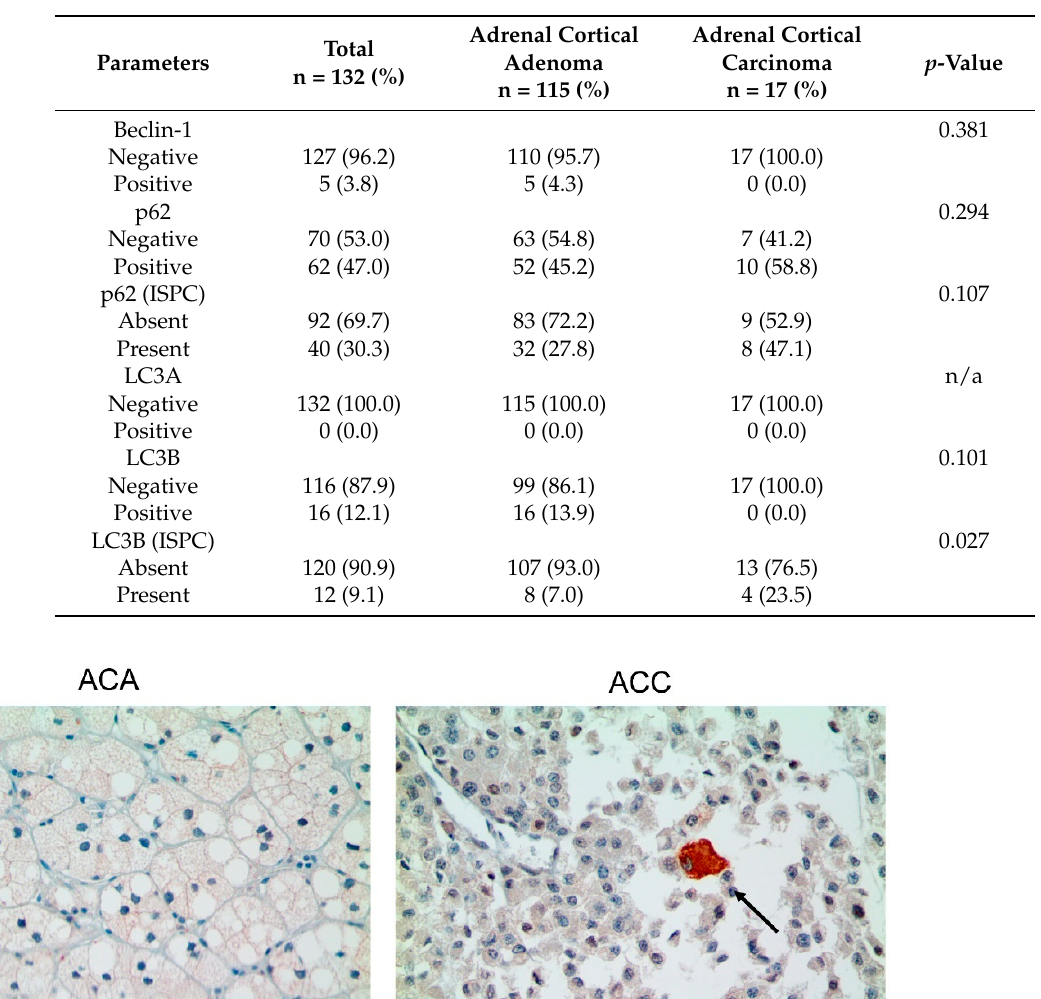
Table 2. Expression of autophagy-related proteins in adrenal cortical adenoma and adrenal corti-